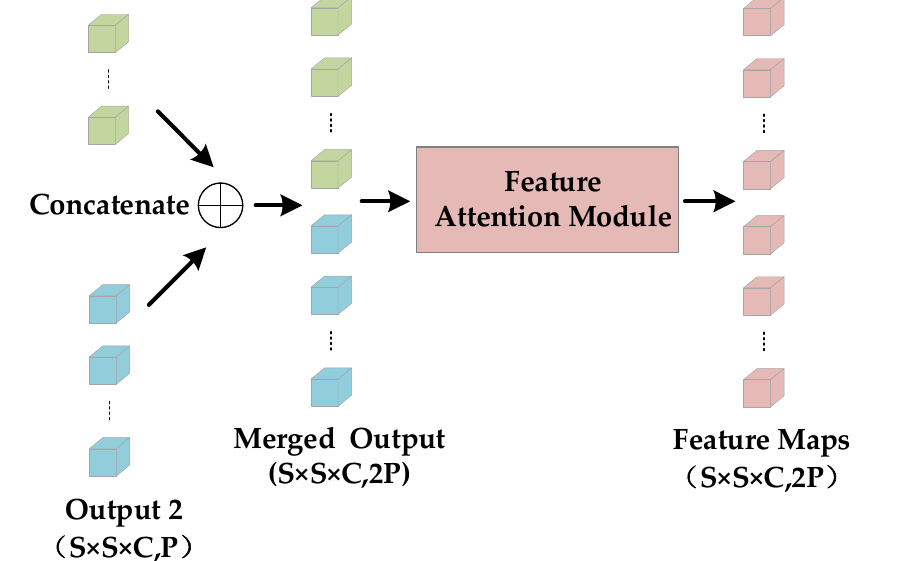
Figure 11. Co-training model.